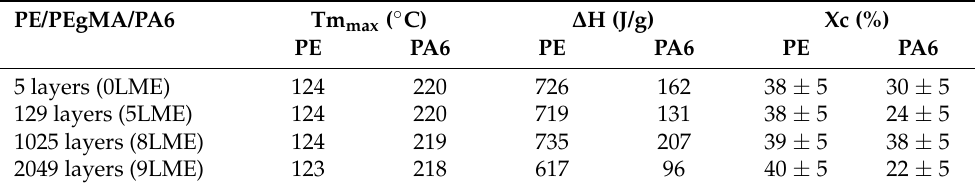
Figure 3. DSC for PE/PEgMA/PA6 multilayer films made by 0 LME (5 layers), 5 LME (129 layers), 8 LME (1025 layers) and 9 LME (2049 layers). Table 1. Melting temperatures, melting enthalpy and degree of crystallinity determined from PE/PEgMA/PA6 films by DSC